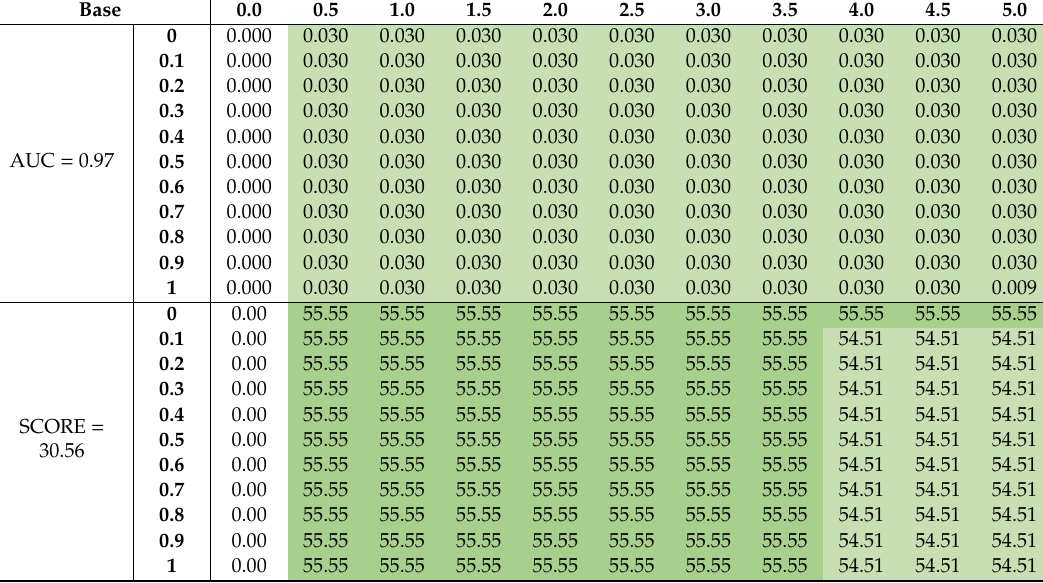
Table 7. Improvement of AUC and Score for Ventricular Fibrillation or Flutter on validation sample in terms of the α -parameter and p